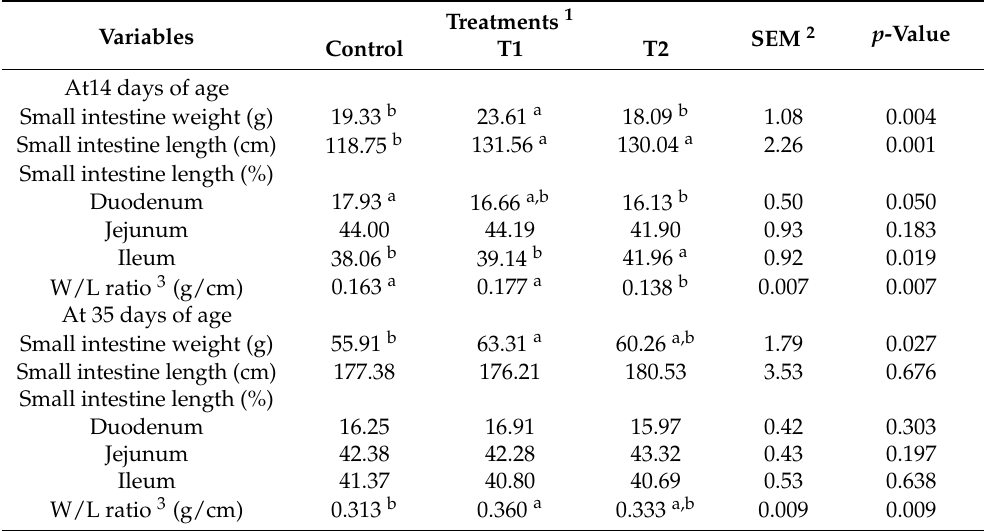
Figure 2. Histological changes in the kidney of broiler chickens stained with (H&E) 100 × to 400 × . Control, birds receiving basal diet; T1, basal diet containing 0.75 g Tribulus Terrestris /kg feed; T2, basal diet containing 1.5 g Tribulus Terrestris /kg feed. The kidney of the chickens (control) showed interstitial hemorrhage and congestion in the renal blood vessels (striped arrow) with degeneration of the epithelial lining of the renal tubules (star) with accumulation of inflammatory cells (arrowhead). In contrast, all histopathological changes improved in chickens fed diets T1 to T2 (0.75 or 1.5 g TT powder per kg diet). Table 7. Effect of Tribulus Terrestris (TT) supplementation on the intestinal morphology in broiler